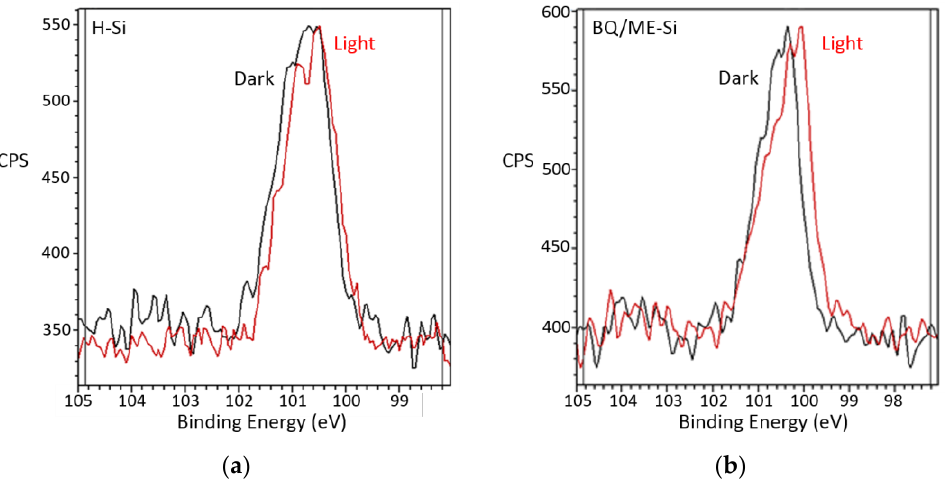
Figure 2. n-type silicon peak shift with light on and off for H-Si ( a ) and BQ-Si ( b ).